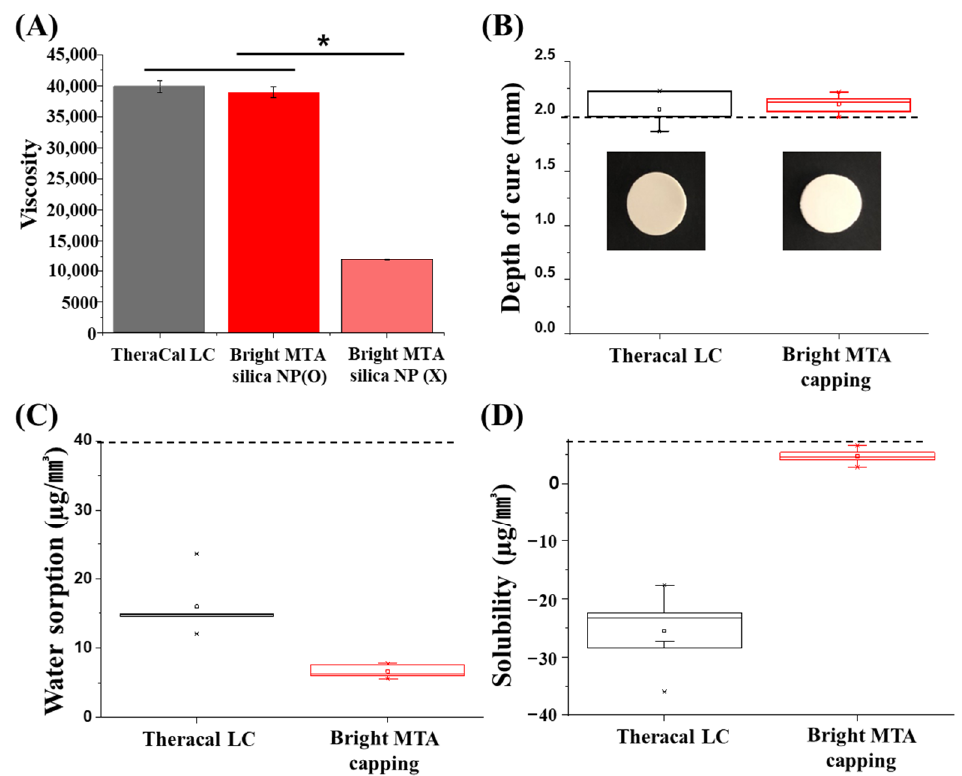
Figure 1. Physiochemical properties of TheraCal LC and bright MTA capping. ( A ) Viscosity comparison of TheraCal LC and bright MTA with silica nanoparticle (NP) or without (n = 5, at 24.7 °C p < 0.05). Asterisks (*) indicate statistical significance between specimen’s viscosity ( p < 0.05). ( B ) Depth of cure (n = 5) of TheraCal and bright MTA capping was approximately 2.0 mm and 2.1 mm, respectively. According to ISO4049, opaque shade restorative materials are > 2.0 mm. ( C ) Water absorption of TheraCal and bright MTA capping was 0.133 µ g/mm 3 and 0.066 µ g/mm 3 on average. According to ISO4049, at least four of the values obtained are ≤ 40 µ g/mm 3 . ( D ) Water solubility (n = 5) of TheraCal and bright MTA capping was 0.025 µ g/mm 3 , 0.004 µ g/mm 3 on average. According to ISO4049, at least four of the values obtained were ≤ 7.5 µ g/mm 3 .